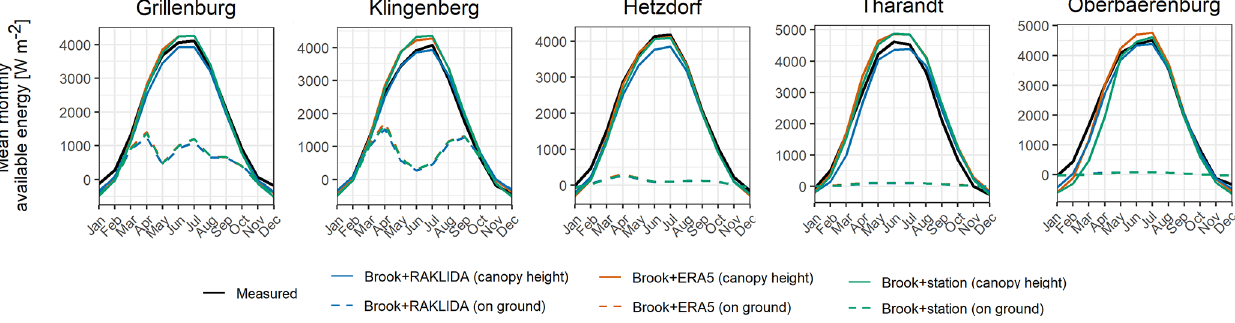
Figure 9. Observed and modelled monthly mean grass-reference